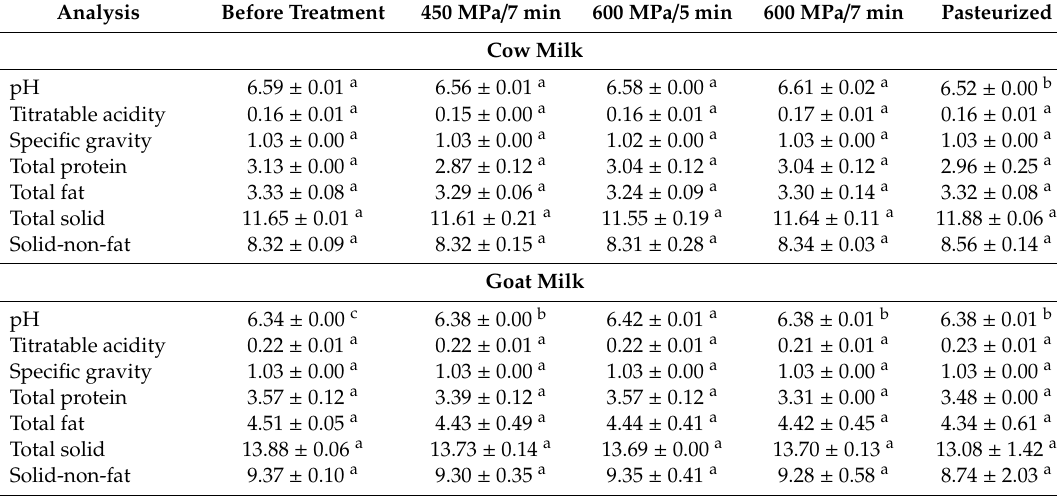
Table 1. Physico-chemical properties of cow and goat milk before and after